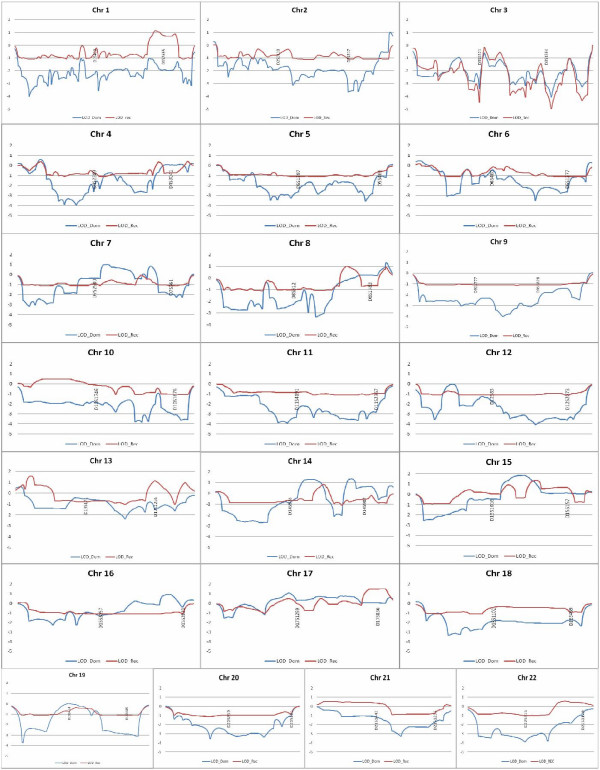
Whole genome linkage analysis with 500 polymorphic microsatellite markers. The results of parametric linkage analysis with SimWalk. In blue, the dominant model; in pink, the recessive model.